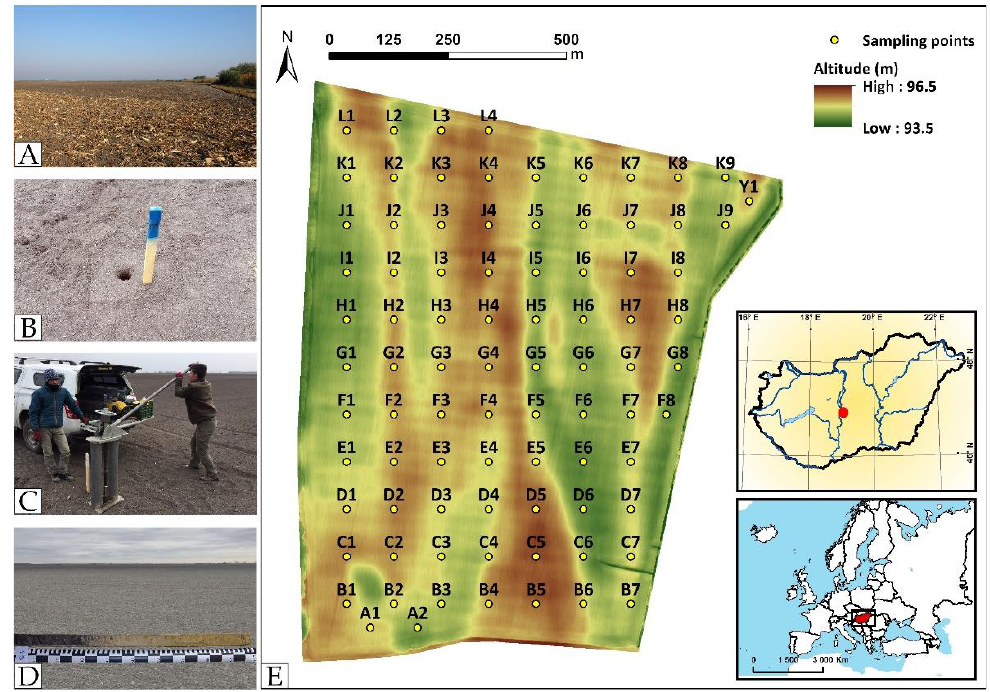
Figure 1. ( A ). Photo of the sampling plot ( B ). Photo of the field marking of the borehole ( C ). Photo of soil sampling with motorized hand drill ( D ). Photo of the undisturbed soil column lying in 10 cm diameter soil tube ( E ). Location of the study site in Central Hungary and its high-resolution digital elevation model coming from remote sensing (unpiloted aerial vehicle survey). Sampling points ( n = 85).